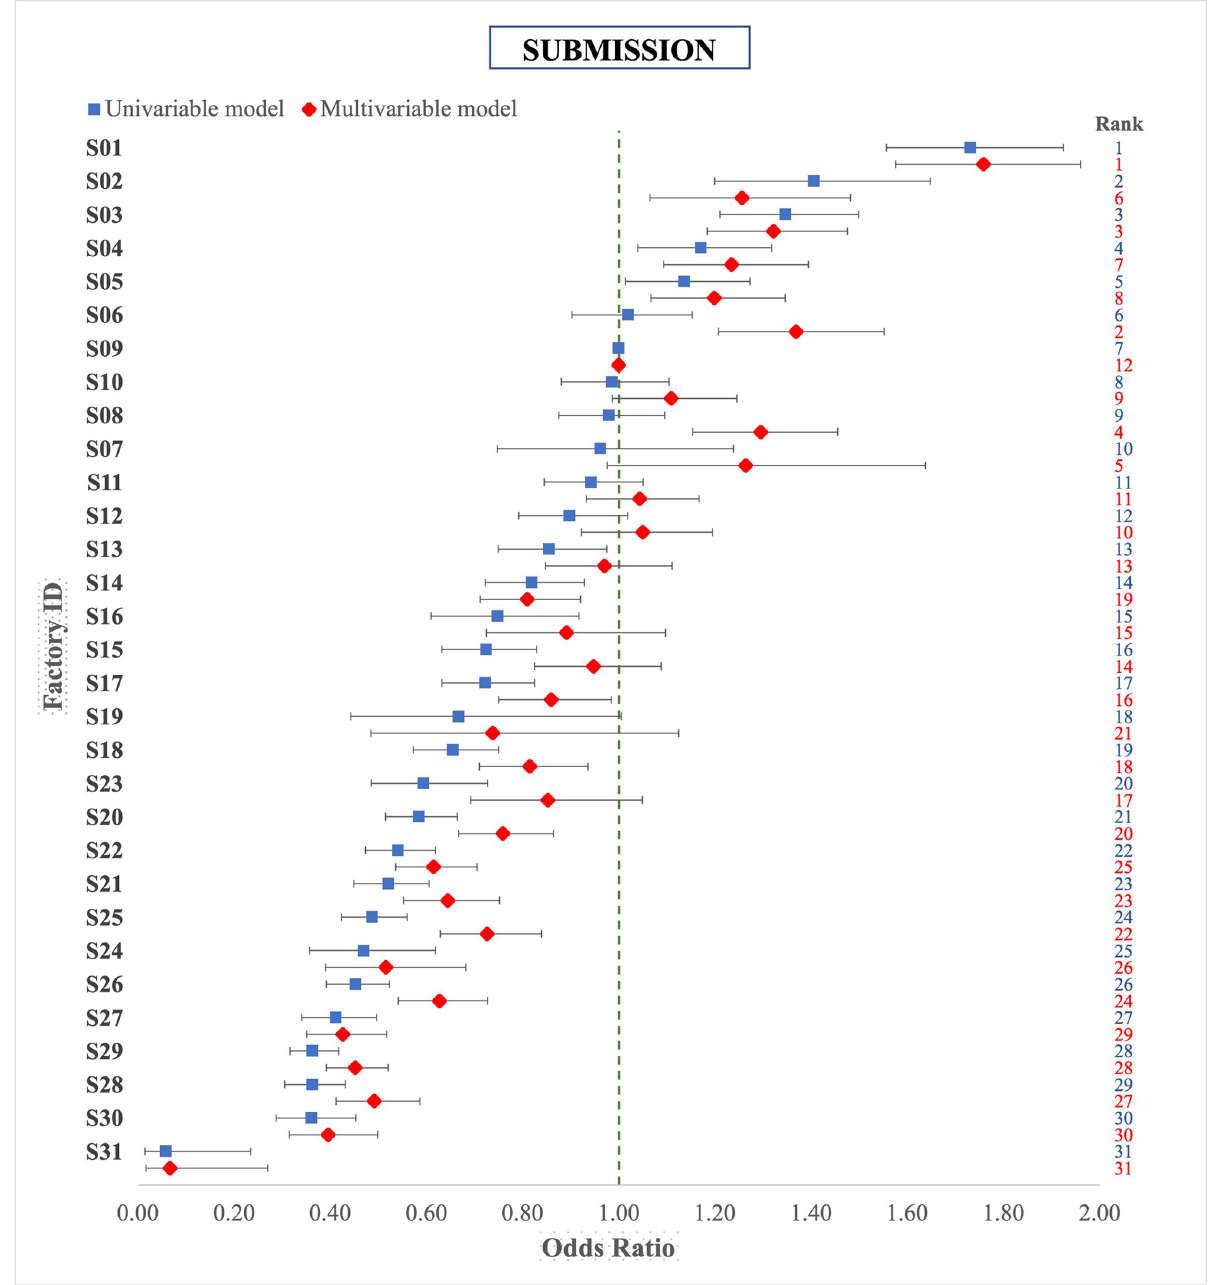
Fig 3. Comparison of factory ranking based on OR derived from univariable and multivariable (adjusted for covariates and random herd effect) logistic regression results of bTB suspected lesion submission from animals slaughtered (n = 6,578,245) in Irish factories in the period 2014– 2018. S09 = reference